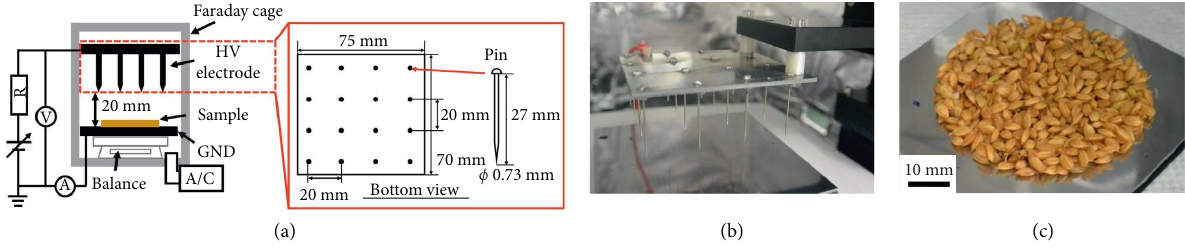
Figure 1: (a) Schematic diagram of the experimental set-up; (b) photograph of the electrode; and (c) the target